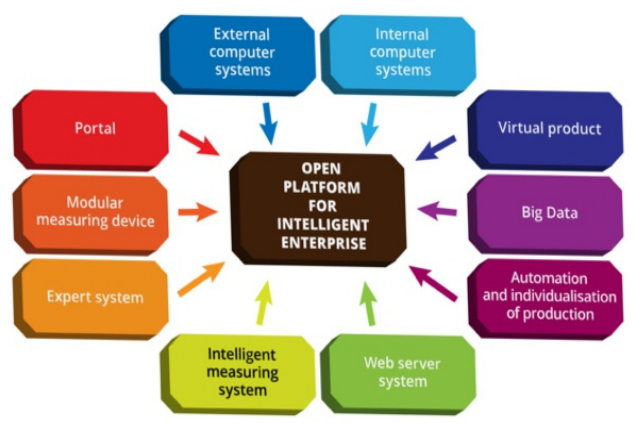
Figure 1. An open platform model for an intelligent enterprise system.